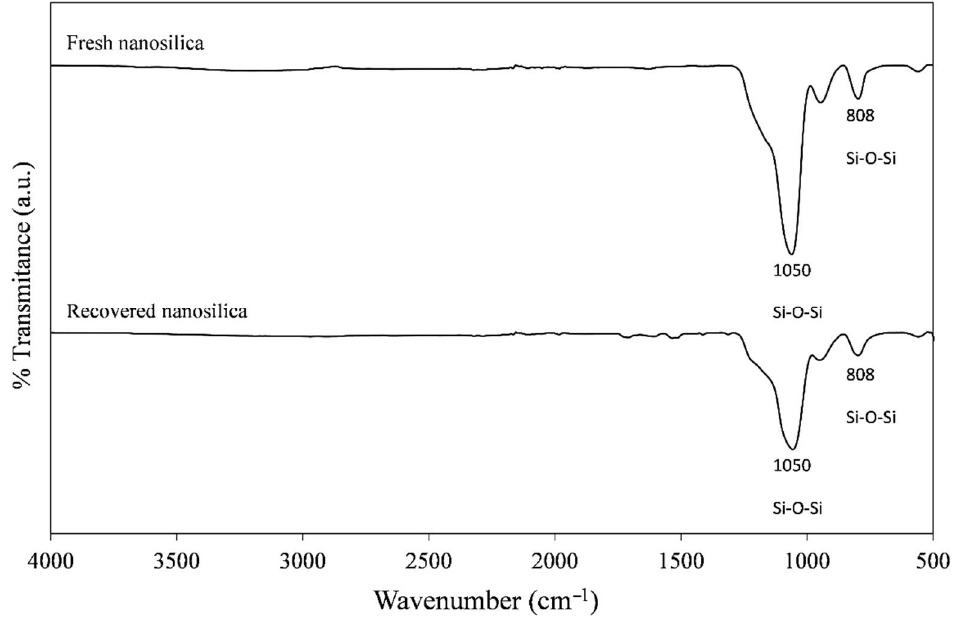
Figure 6. Comparison of FTIR spectra of the fresh and recovered nanosilica.